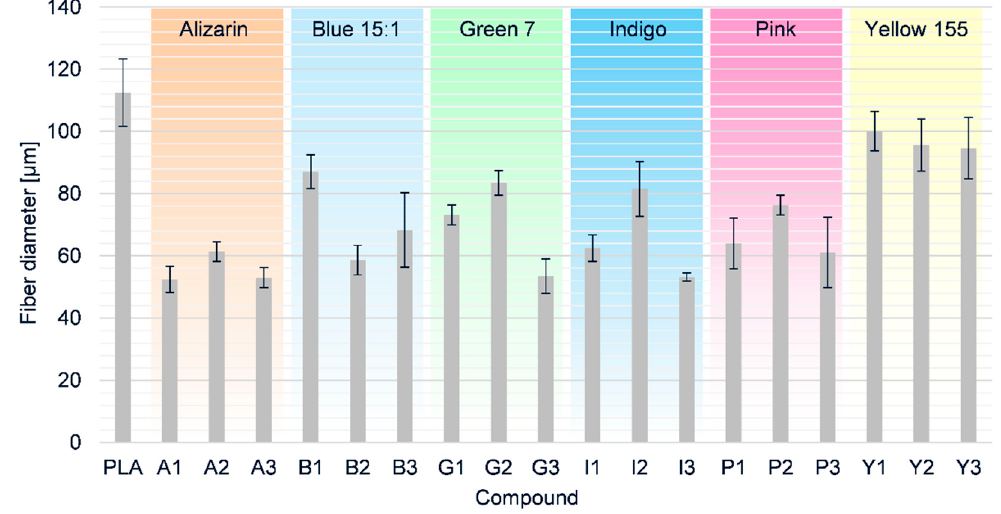
Figure 14. Fiber diameters and standard deviations of PLA and its composites containing 1%, 2% and 3% (w/w) of each additive produced by melt electrospinning at 275 °C using a single-nozzle laboratory device.